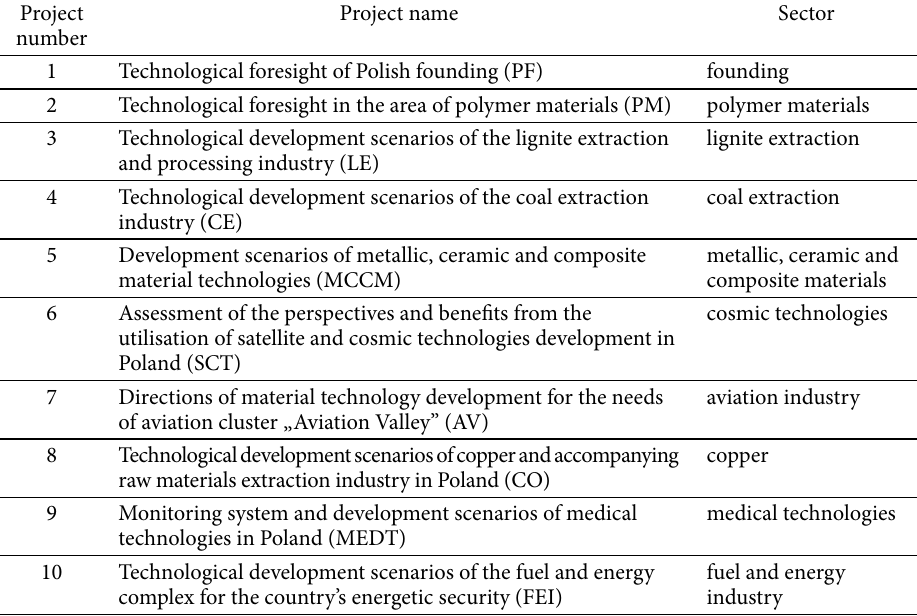
Table 1. List of sectoral foresight projects in which scenario method has been applied